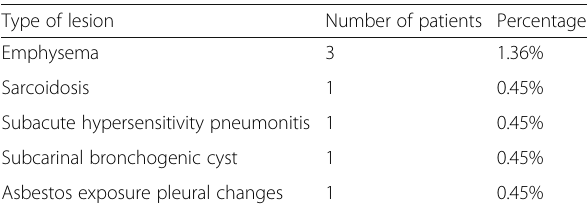
Table 6 A summary of associated other pulmonary and chest lesions